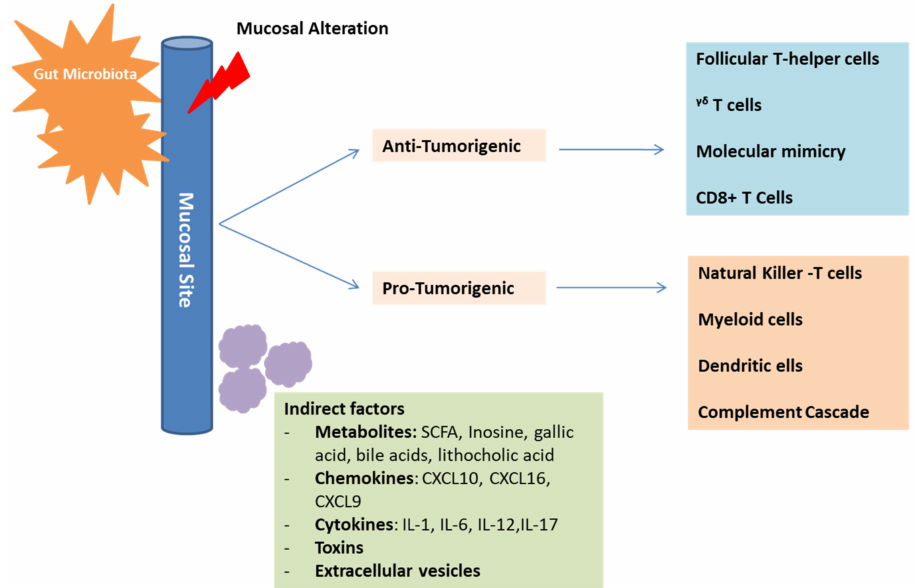
Figure 3. Mechanisms of gut microbiota in cancer development and immunosurveillance. The gut microbiota plays an essential role in influencing the immune-system composition and function. This is possible through direct, as well as indirect interactions with the immune-system compo- nents. These interactions can have positive anti-tumorigenic effects on some cells and negative immunosuppressive pro-tumorigenic effects on other cells, depending on the established microbiota profile. Mediators of indirect interactions include metabolites, chemokines, cytokines, toxins, and extracellular